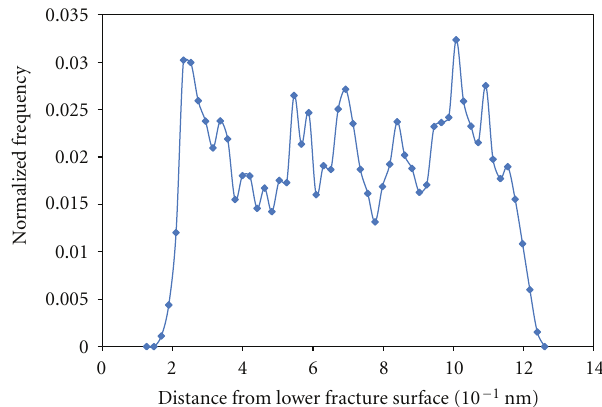
Figure 2: The ordering of water molecules during molecular dynamics simulation of the region in between the two Ni(100) fracture surfaces exposed to water. The normalized frequency refers to the frequency with which oxygen may be found at a given distance from the electrode surface, normalized such that the integrated frequency goes to